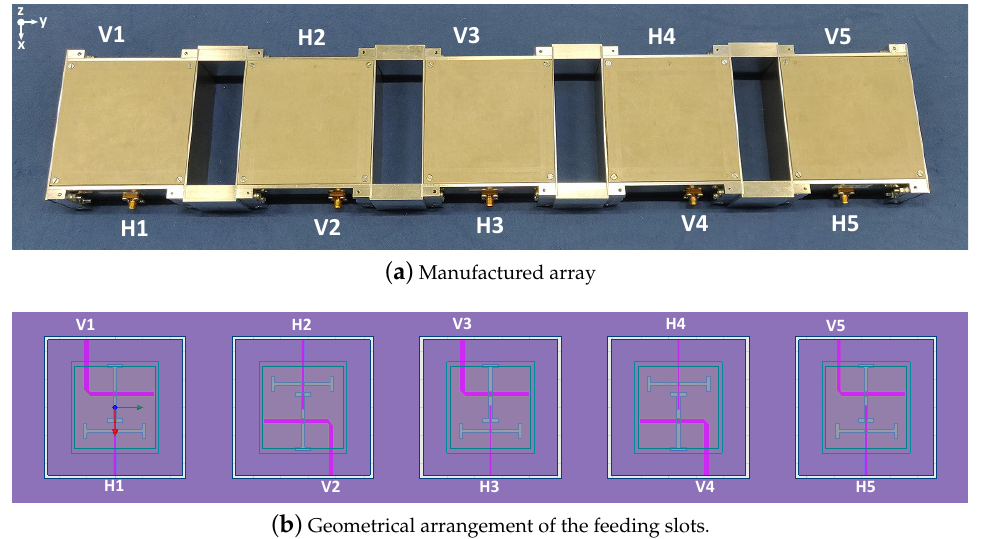
Figure 11. Manufactured array performing a 180° rotation of antenna elements 2 and 4.